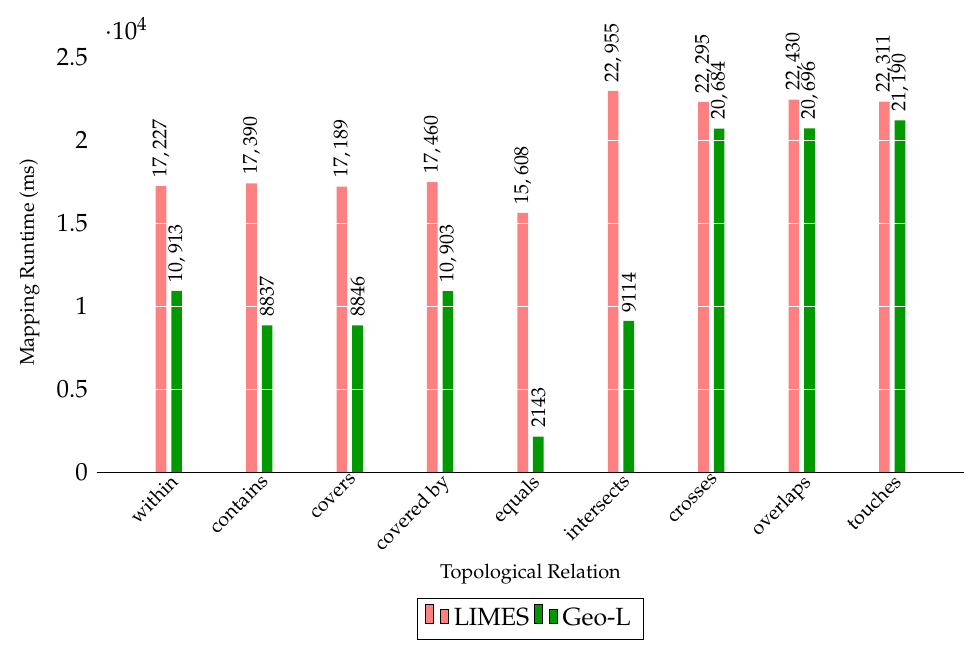
Figure 4. Performance OLU–OLU; size: 400 · 10 3 × 400 · 10 3